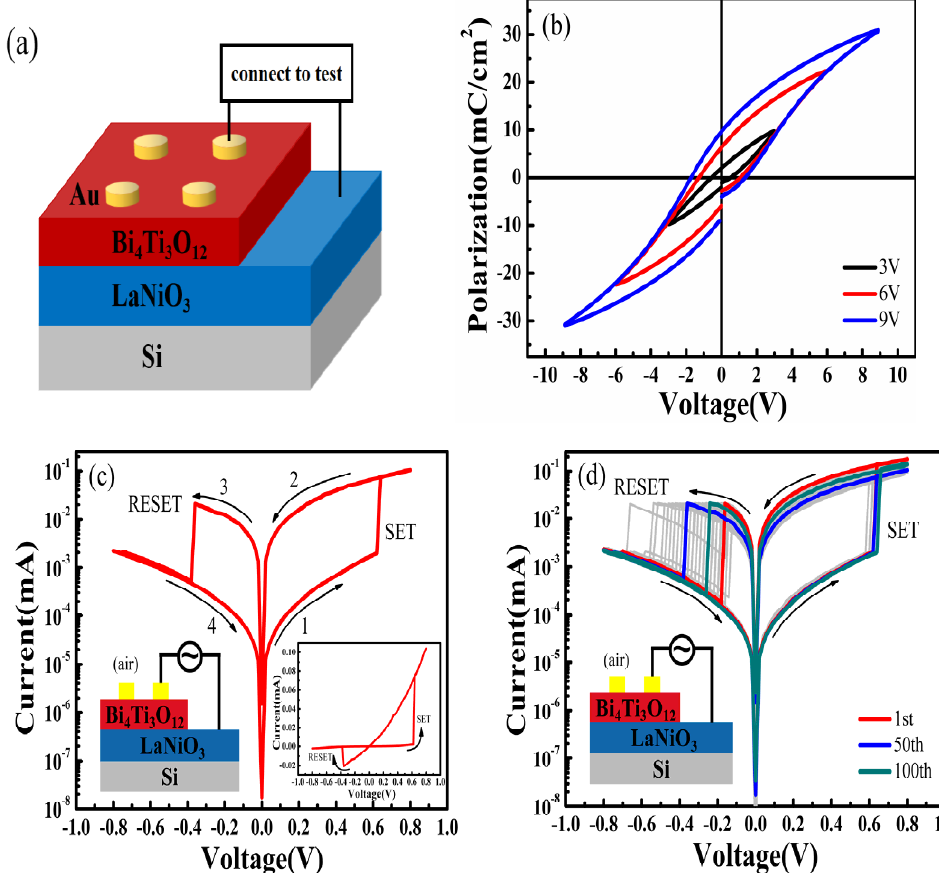
Figure 3. ( a ) Schematic drawing of the Au/BIT/LNO/Si device. ( b ) P − V loops of the device at 1 KHz by increasing the voltage sweep range. ( c ) Semilogarithmic I − V curve. The inset shows the I − V curve of the device. ( d ) Semilogarithmic I − V curve of the device under 100 voltage sweep cycles.